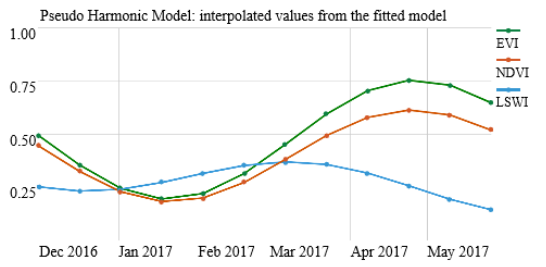
Figure 4. Generated VIs at equal-intervals starting December 1 st in the Mymensingh example.